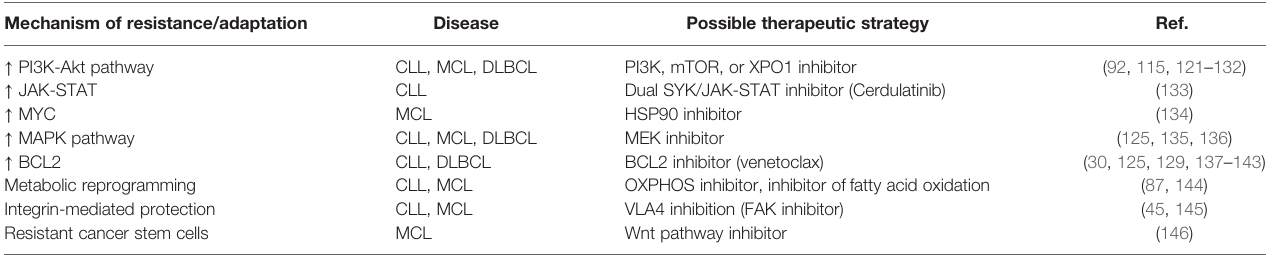
↑ represents pathway/gene activation or